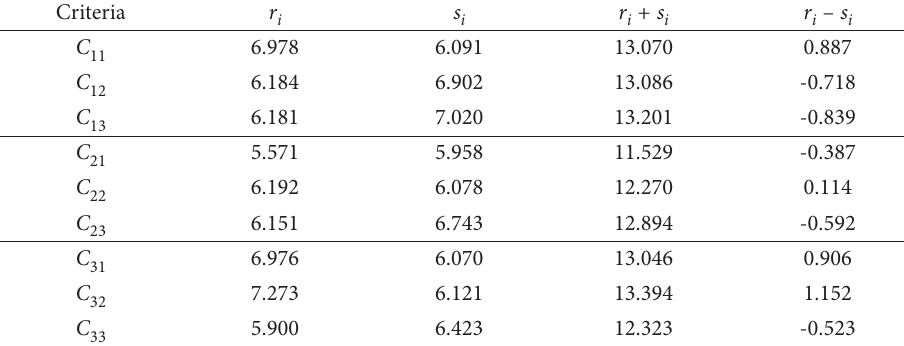
Table 6. The influential network relation on criteria Criteria r i